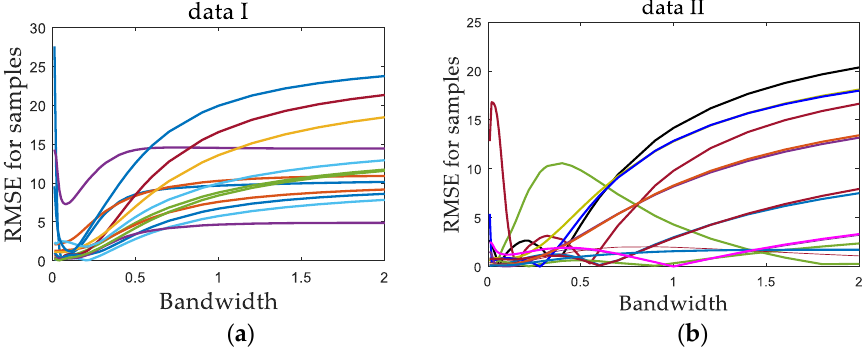
Figure 2. Root mean square error (RMSE) curves with different bandwidth values: ( a ) data set I; ( b ) data set II.